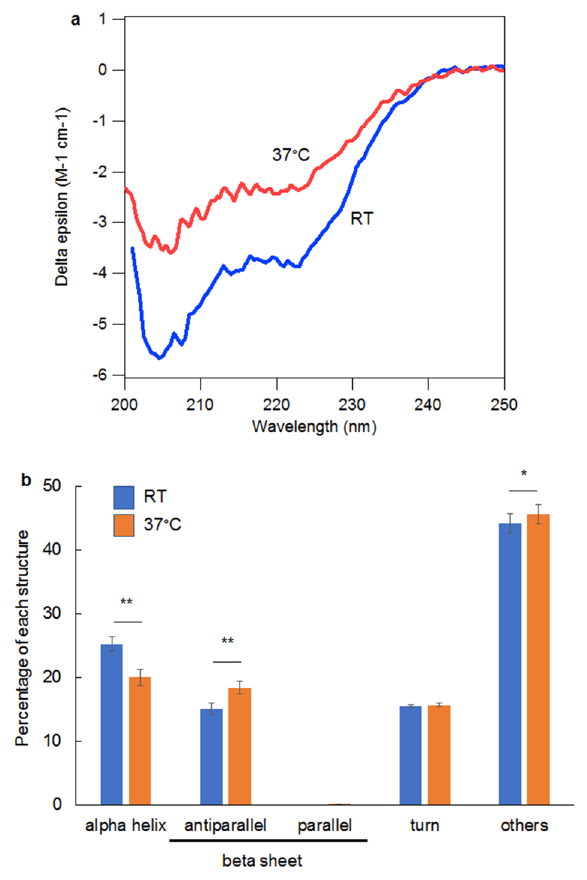
Figure 1. Secondary structure of a peptide with 13 alanine repeats under multiple temperature conditions. ( a ) Representative circular dichroism spectra of a 13A peptide (100 µg/mL in water) incubated for 4 h at room temperature (RT) or 37 °C. ( b ) The spectra (each n = 18) were analyzed using the BeStSel software to determine the percentages of following: alpha-helix, anti-parallel beta-sheet, parallel beta-sheet, turn and other structures. Each error bar represents the SE. ANOVA followed by posthoc test, *p < 0.05, **p <